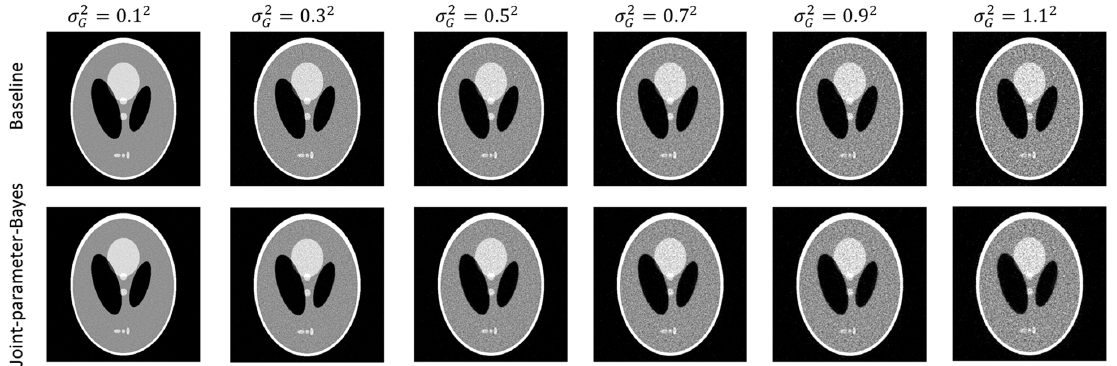
Figure 2. Comparison of reconstructed images between the conventional MAP ( top row ) and joint ‐ parameter ‐ Bayes ( bottom row ). The display window is [0, 0.035] mm − 1 . Table 1 Quantitative comparison of the conventional MAP (baseline) and joint ‐ parameter ‐ Bayes. Conventional MAP (Baseline) Joint ‐ Parameter ‐ Bayes 𝜎 (cid:3008)(cid:2870)